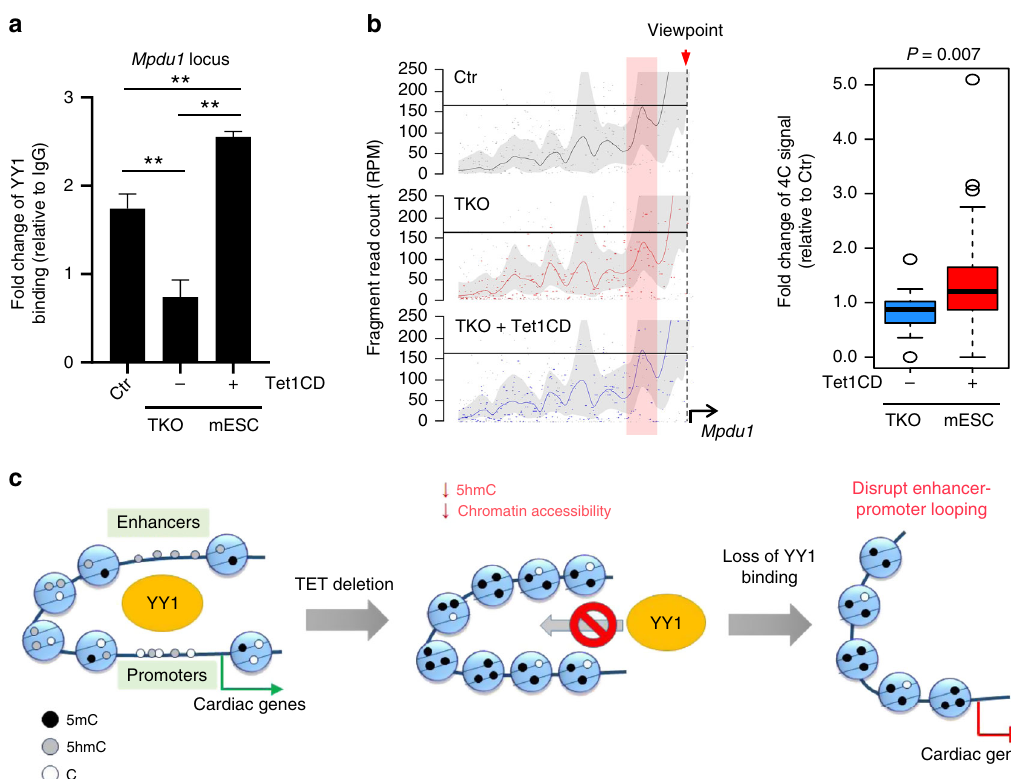
Fig. 8 Re-expressing Tet1CD partially restores the YY1 mediated enhancer-promoter interactions. a ChIP-qPCR analysis of YY1 binding at the Mpdu1 locus in TKO mESCs and TKO mESCs after expression of Tet1CD. Data were shown as mean ± S.D; n = 2 independent experiments. ** p < 0.005 (two-tailed Student ’ s t -test were used). b Representative 4C-seq signals in WT (black), TKO (red) and TKO + Tet1CD (blue) mESCs at the Mpdu1 locus. The line indicates the normalized 4C-seq signals (calculated by Basic4C-seq R package using two biological replicates) and the shaded areas represent the 95% con fi dence interval. The quanti fi cation of 4 C signals at red highlighted regions were shown in the right panel. Blue: relative fold-change of 4 C enrichment between TKO and WT (TKO/WT); Red: relative fold-change of 4C enrichment between TKO + Tet1CD and WT (TKO + Tet1CD/WT). All the experiments were performed with biological duplicates. Kolmogorov – Smirnov test were used to calculate p -value. c Tet protein mediated DNA hydroxymethylation regulates chromatin accessibility and subsequently safeguards the binding of key cardiac development-associated transcription factors, such as YY1, to their target regions in the genome to maintain proper long distance interactions (enhancer-promoter looping). Deletion of Tet protein, with